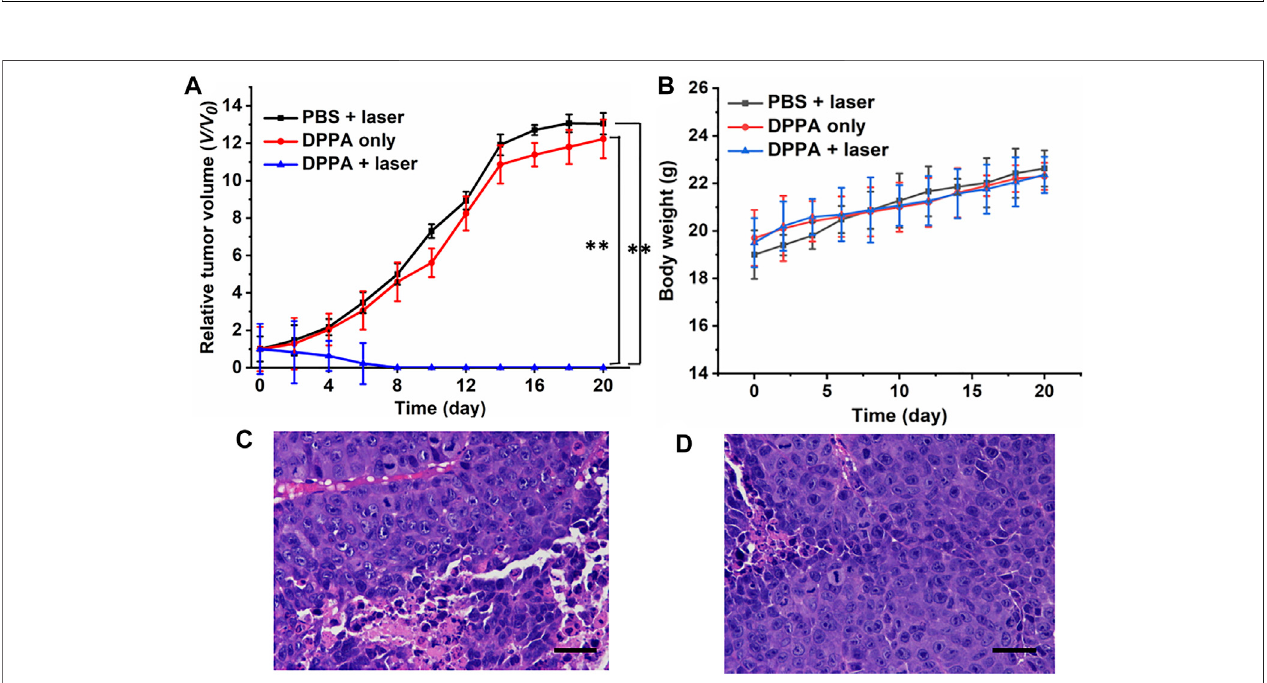
FIGURE 5 | (A) Relative tumor volume of the mice in PBS + laser, DPPA-only, and DPPA + laser groups (660 nm, 500 W/cm 2 , 8 min). (B) Body weight change. (D) H&E stained pictures of the tumor in the (C) PBS + laser and (D) DPPA-only groups. Scale bar: 10 μ m.